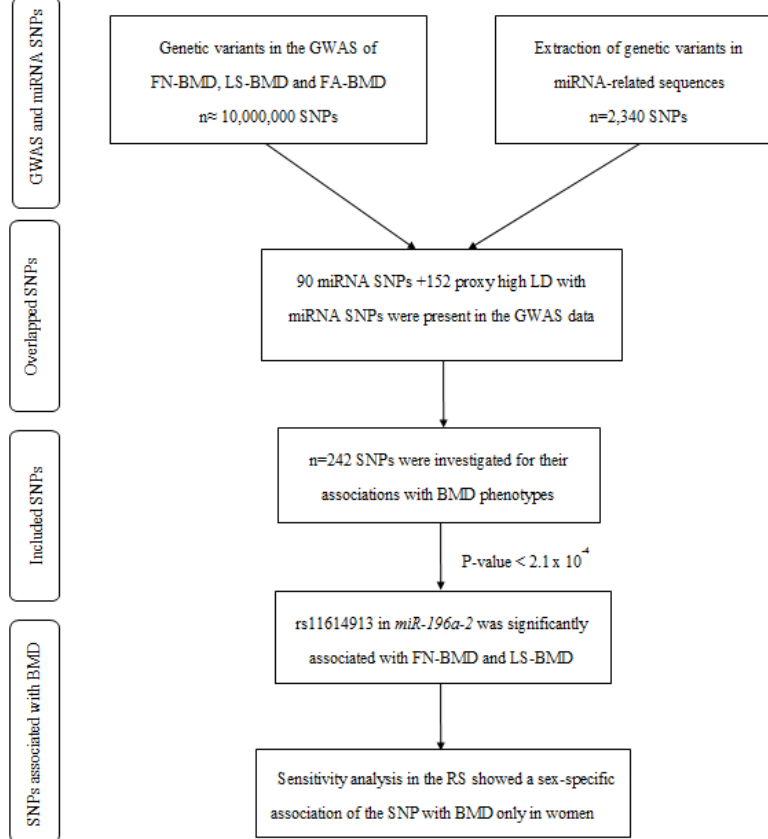
Figure 1. A simplified diagram of the pipeline used to identify miRNA genetic variants associated with BMD. FN-BMD: Femoral neck bone mineral density; LS-BMD: Lumbar spine bone mineral density; FA-BMD: Forearm bone mineral density; SNP: Single-nucleotide polymorphism; GWAS: Genome-wide association studies.